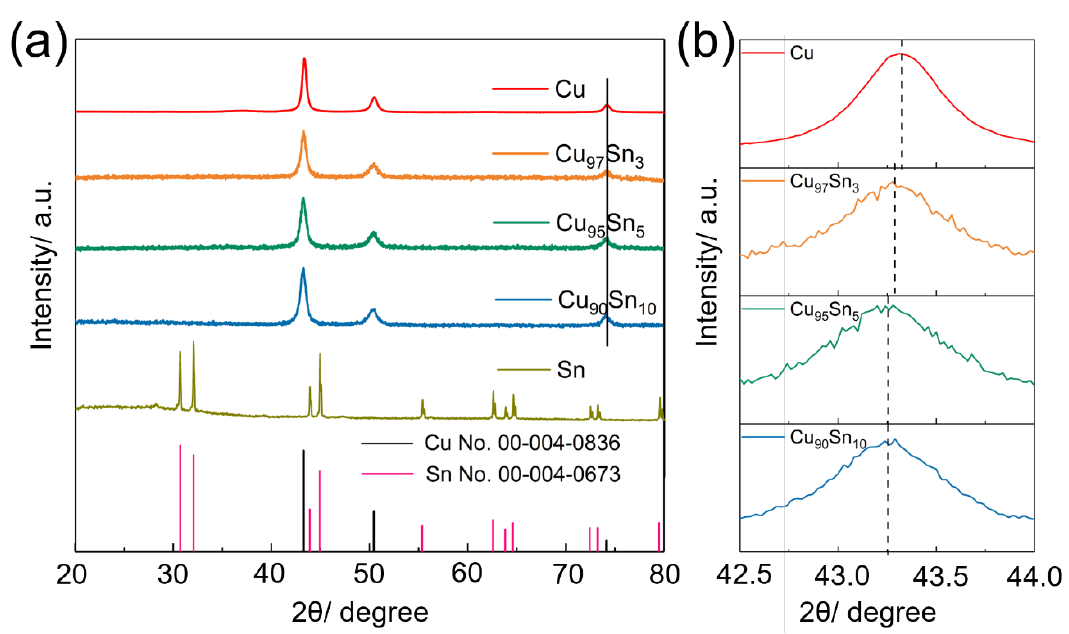
Figure 1. ( a ) XRD patterns of Cu, Cu 97 Sn 3 , Cu 95 Sn 5 , Cu 90 Sn 10 , and Sn aerogels, and ( b ) the closer view of (111) peak.